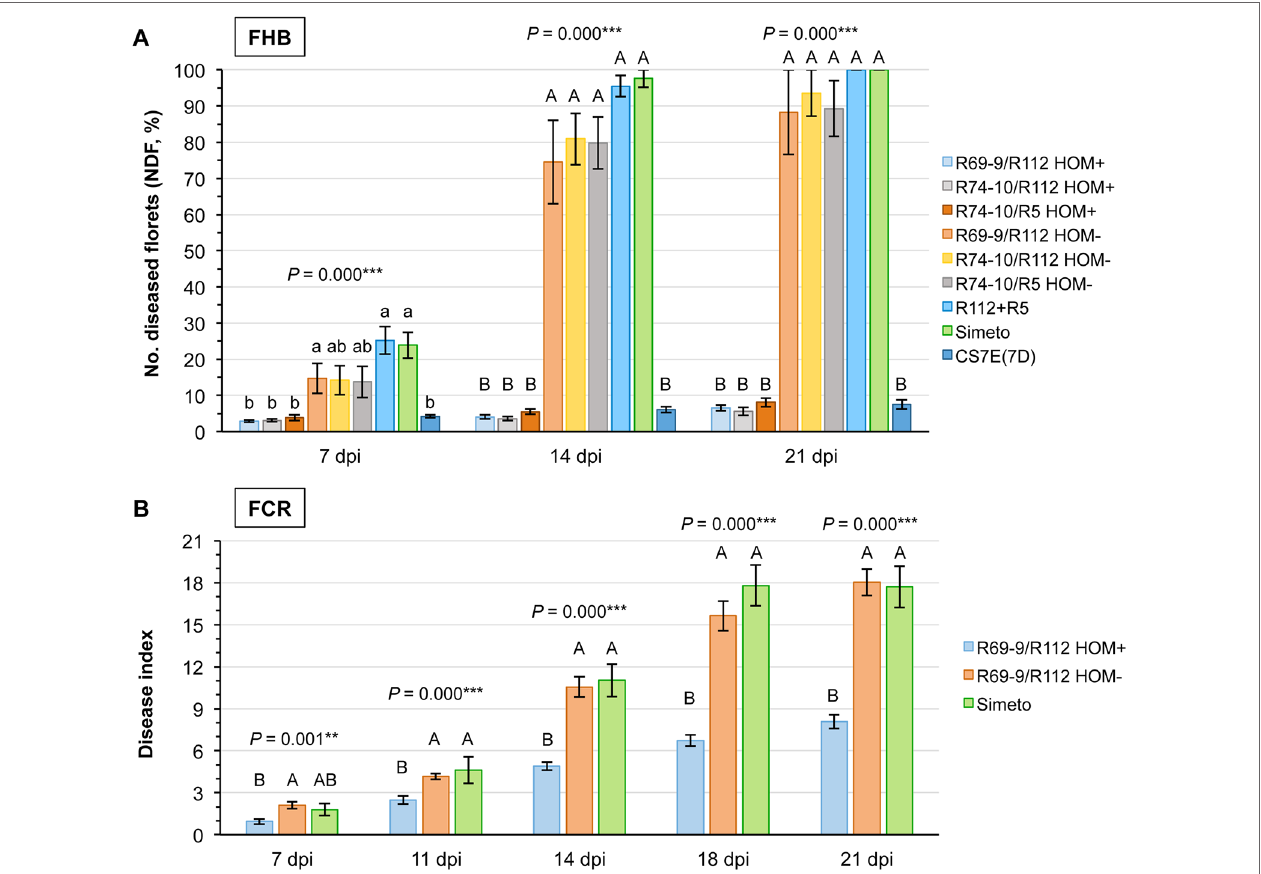
FIGURE 3 | Evaluation of FHB (A) and FCR (B) symptom development at different time-points following inoculation (dpi = days post-inoculation) in durum wheat homozygous carriers (HOM+) and non-carriers (HOM− segregates and cv. Simeto) of the Fhb-7EL QTL. The hexaploid CS7E(7D) original donor line of Fhb-7EL is included as FHB resistant control in (A) . Data at all time points were subjected to ANOVA analysis, and significant F values indicated by ** P < 0.01 and *** P < 0.001,